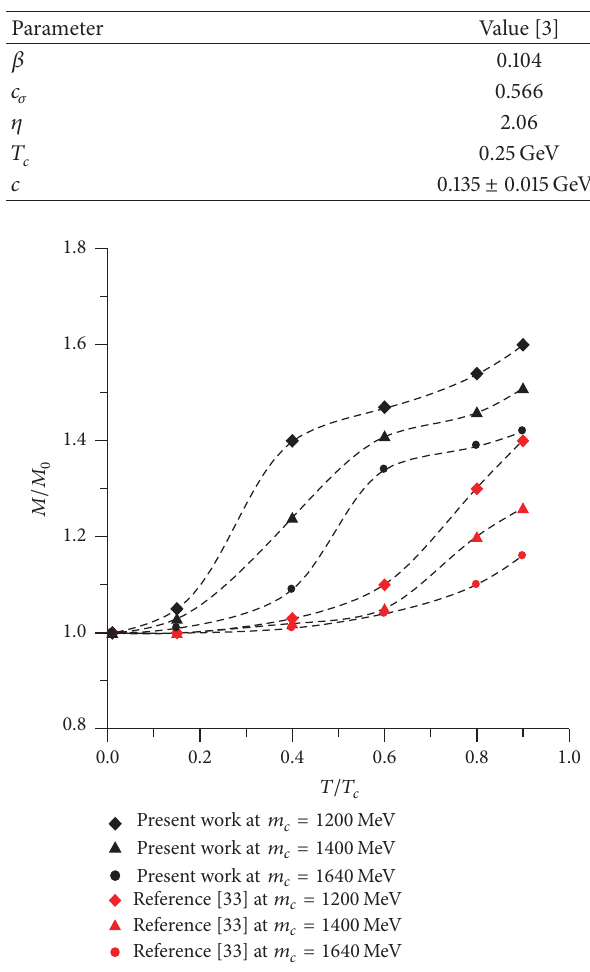
Figure 1: Mass in vacuum mass units of charmonium ground state is a function of temperature in critical temperature units for charm quark mass ( 𝑚 𝑐 ) equal to 1200, 1400, and 1640MeV.